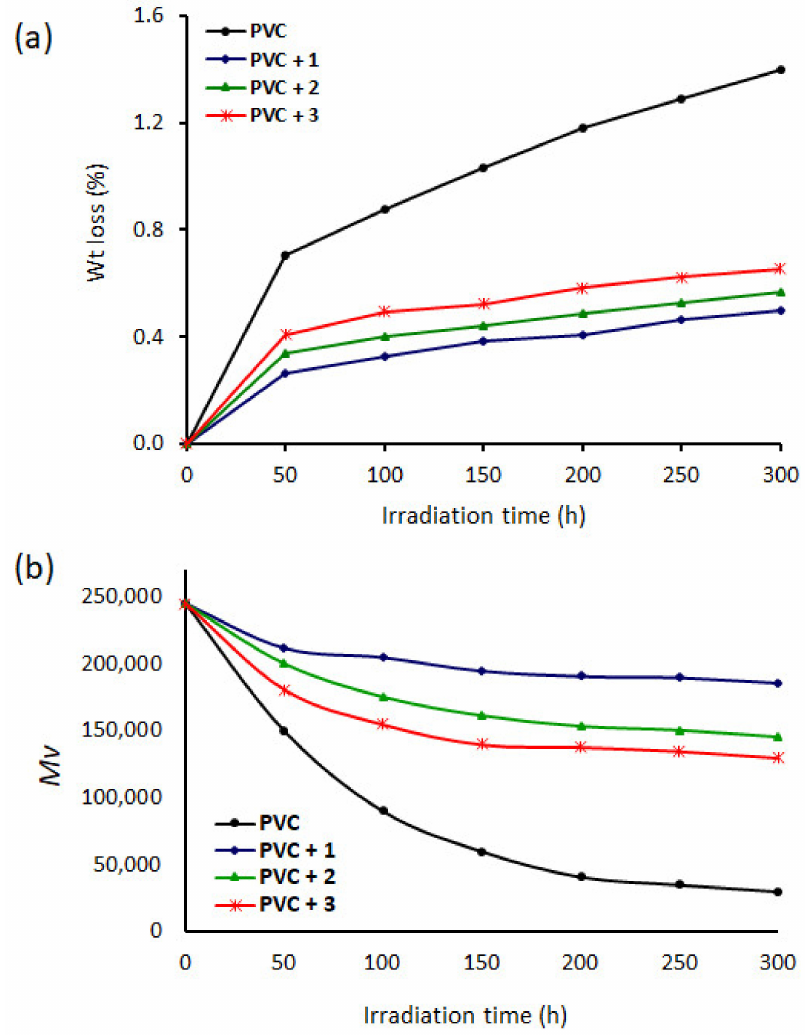
Figure 3. Effect of organosilanes 1 – 3 on the ( a ) weight loss (%) and ( b ) M V of